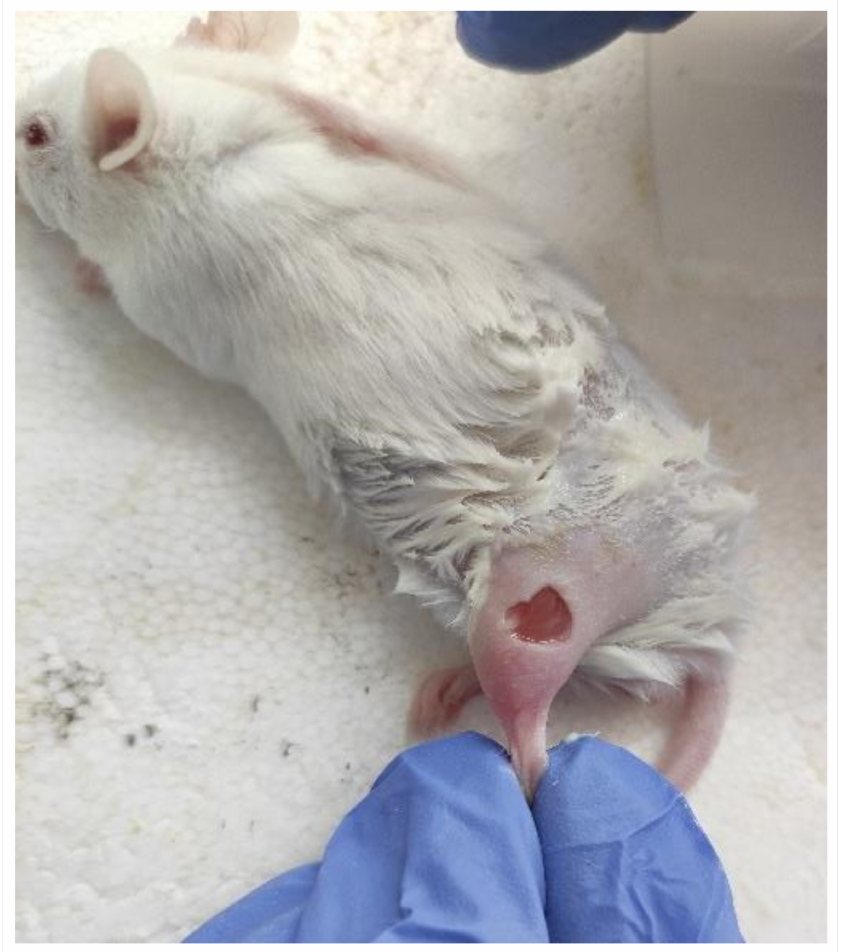
Figure 1. A full-thickness cutaneous